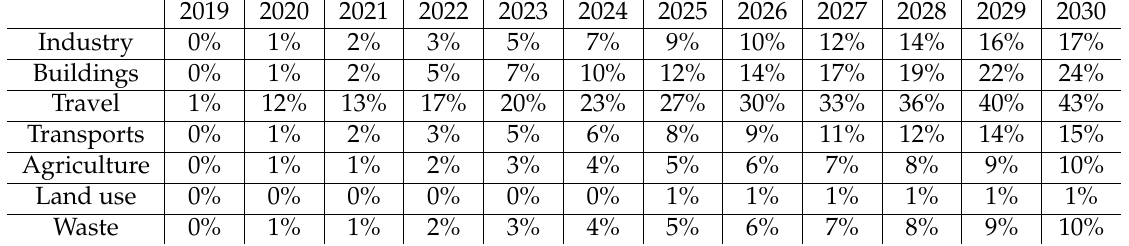
Table 18. Shares of each sectors GHG supply that can be cut by ICT Solutions between 2019 and